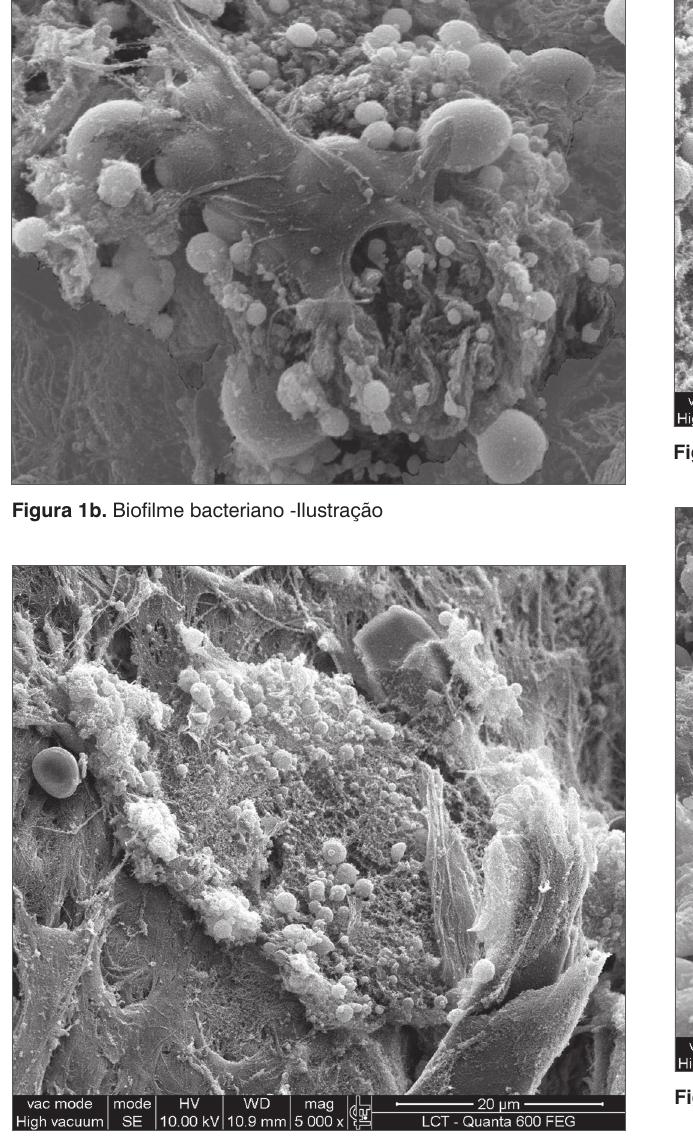
Figura 2. Biofilme bacteriano (aumento 5.000x)